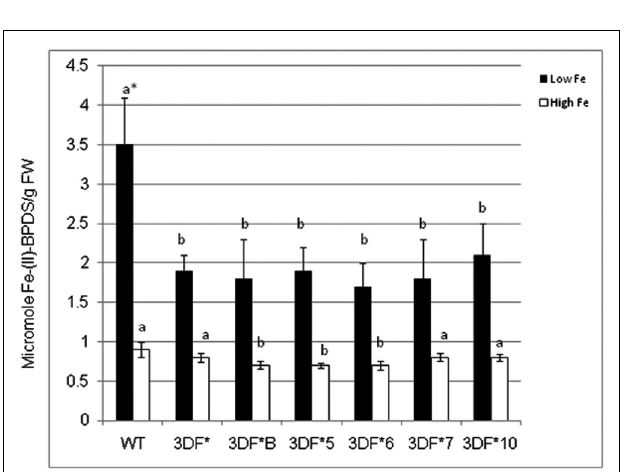
FIGURE 5 | Iron and zinc content of 12-month-old storage roots of greenhouse-grown FEA1 transgenic and wild-type cassava plants. White bars represent zinc and black bars represent iron.WT, wild type; 3DF*, 3DF*B, 3DF*5, 3DF*6, 3DF*7, and 3DF*10 are FEA1 transgenic cassava plants.The results represent the mean of three replicates ( ± standard deviation). *Numbers with same letters show no statistical difference, different letters mean statistical difference at 95% confidence level.